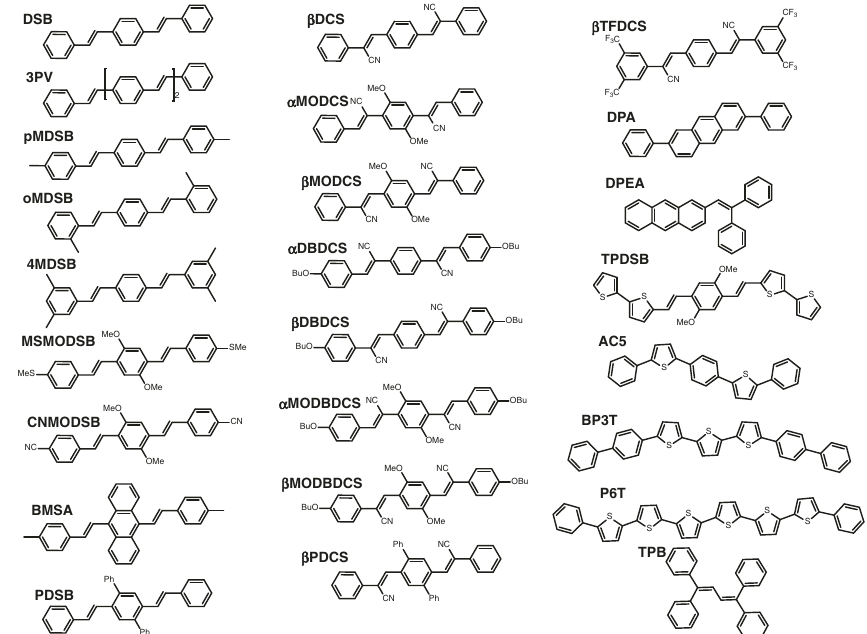
Fig. 1 Group I: single-crystal organic fl uorescent materials investigated in this work. Most of these single-crystal materials are chosen from ref. 6 , with a few up-to-date reported materials.